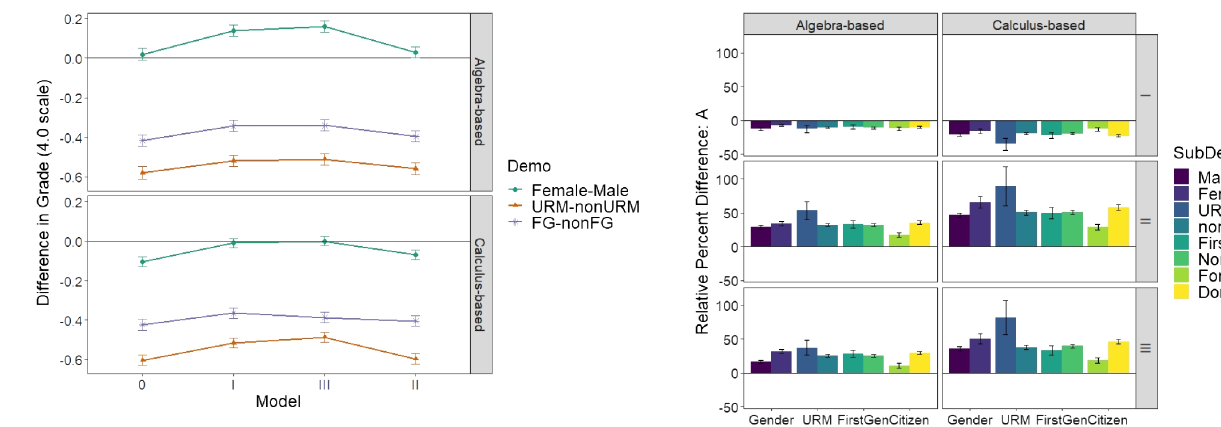
FIG. 3. Demographic differences in grade on a 4.0 scale for each model presented in Table V. The four grading models.